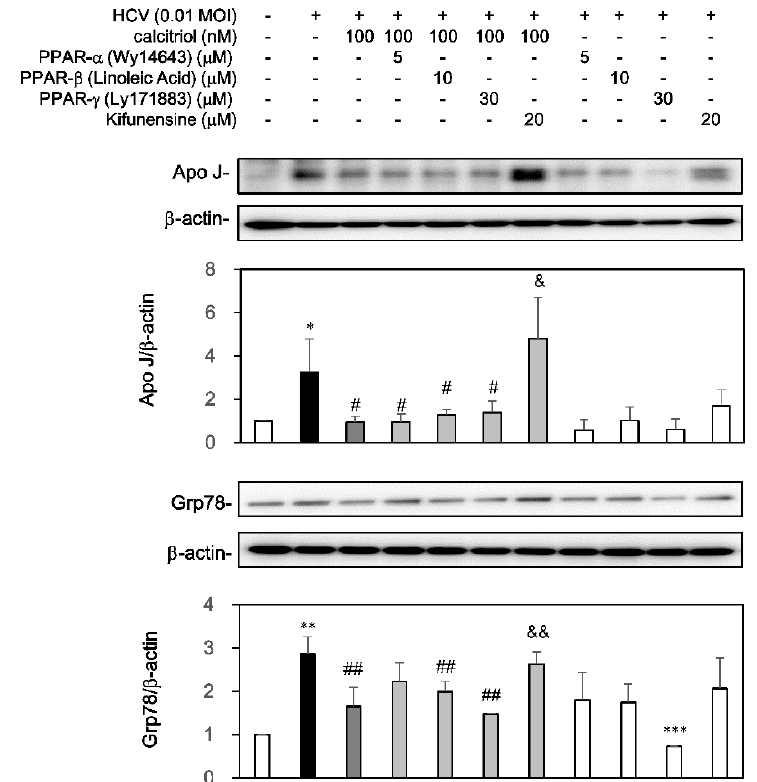
Figure 6. Effects of calcitriol on apoJ and Grp78 in HCV infection. HCV-infected Huh7.5-SEAP cells (7 × 10 5 ) were pretreated with 5 µ M of Wy14643, 10 µ M of linoleic acid, 30 µ M of Ly171883, or 20 µ M of kifunensine for 1 h before calcitriol treatment in a 6-well plate. Cell lysates were collected at day 6 and the apo J, Grp78 and β -actin levels were detected by Western blot. Data are expressed as mean ± SD obtained from three individual cultures. * p < 0.05, ** p < 0.01 and *** p < 0.001 vs. the medium control cells without HCV. # p < 0.05 and ## p < 0.01 vs. the HCV-infected cells. & p < 0.05 and && p < 0.01 vs. the calcitriol-treated group. The symbol (–) and (+) referred to the cells without and with HCV infection, respectively.